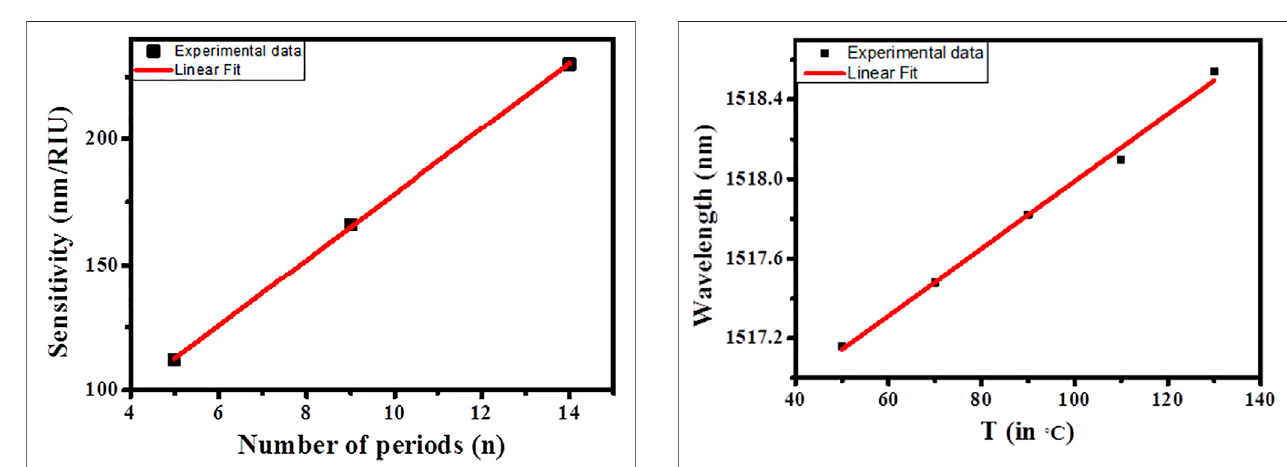
FIGURE 5 | Variation in sensitivity with number of collapsed regions.